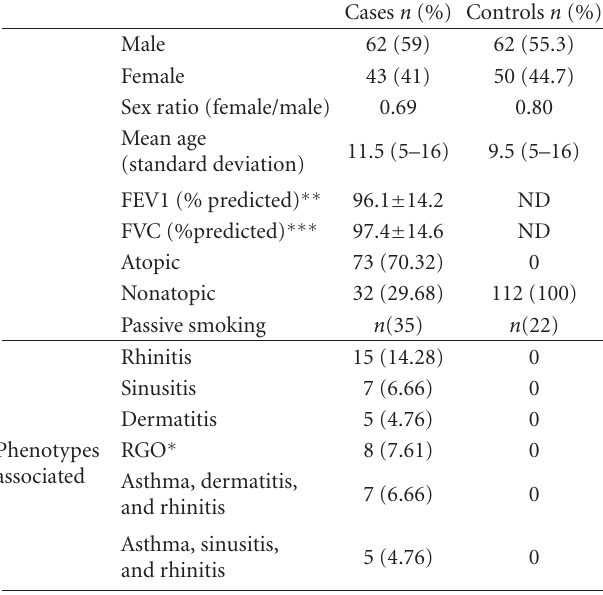
Table 1: The clinical